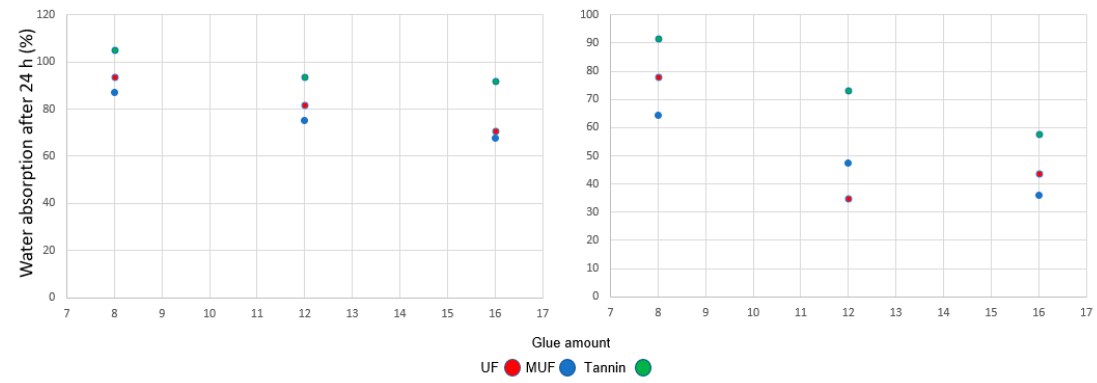
Figure 7. Water absorption after 24 h at three levels of glue amount for 300 kg/m 3 ( left ) and 500 kg/m 3 ( right ) .